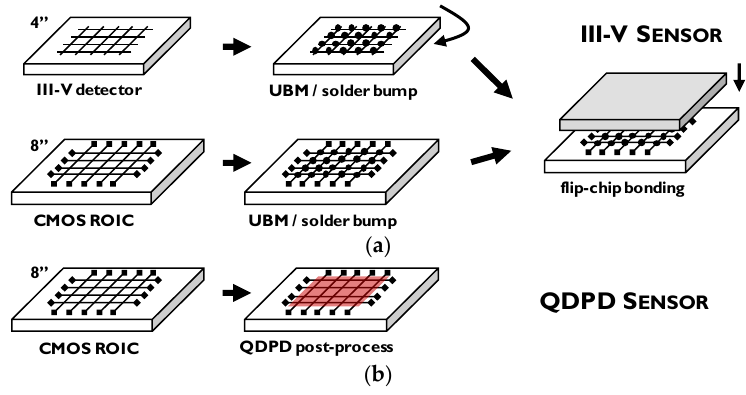
Figure 1. Integration route for a hybrid III–V infrared image sensor ( a ) and a monolithic quantum dot photodiode (QDPD) infrared image sensor ( b ).